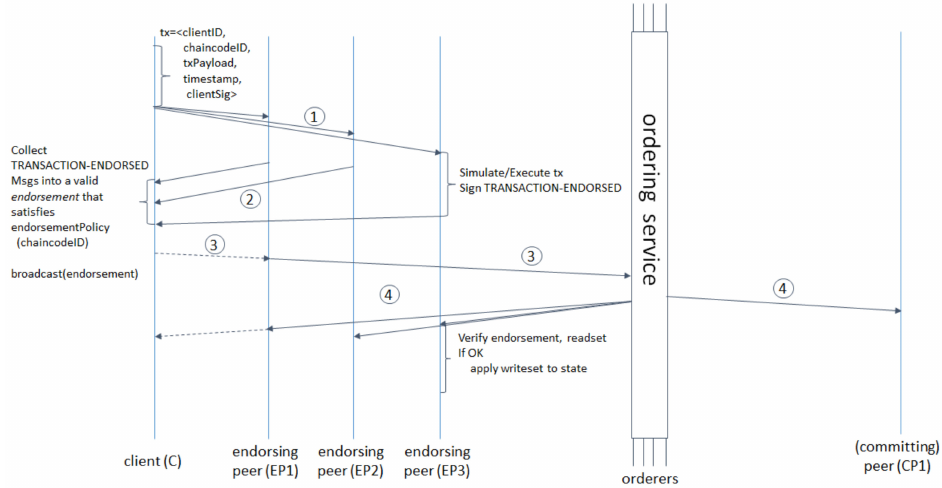
Figure 1. Hyperledger Fabric Transaction Flow